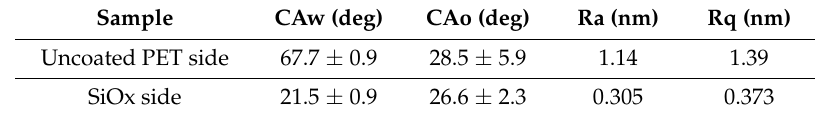
Table 2. Static water and oil contact angle (CAw and CAo, respectively), and film roughness. Sample CAw (deg)